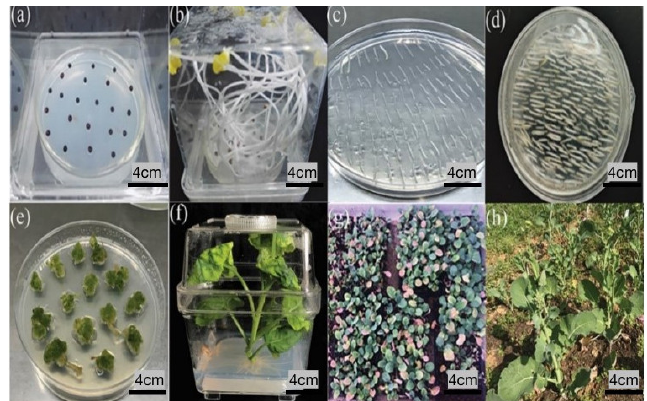
Figure 2. Model of BnaRFL11 with target sequences and the binary plasmid Cas9 vector. ( a ) The BnaRFL11 gene structure is shown in black. The vertical line indicates the gene model, and the arrow shows the sgRNA direction. The target sequences of sgRNAs are represented by PAM sites high- lighted in red. ( b ) The kanamycin resistance cassette is driven by the CaMV35S promoter of the cauliflower mosaic virus. Two sgRNAs are driven by the U6-26p and U6-29p promoters and the U6- 26t terminator.